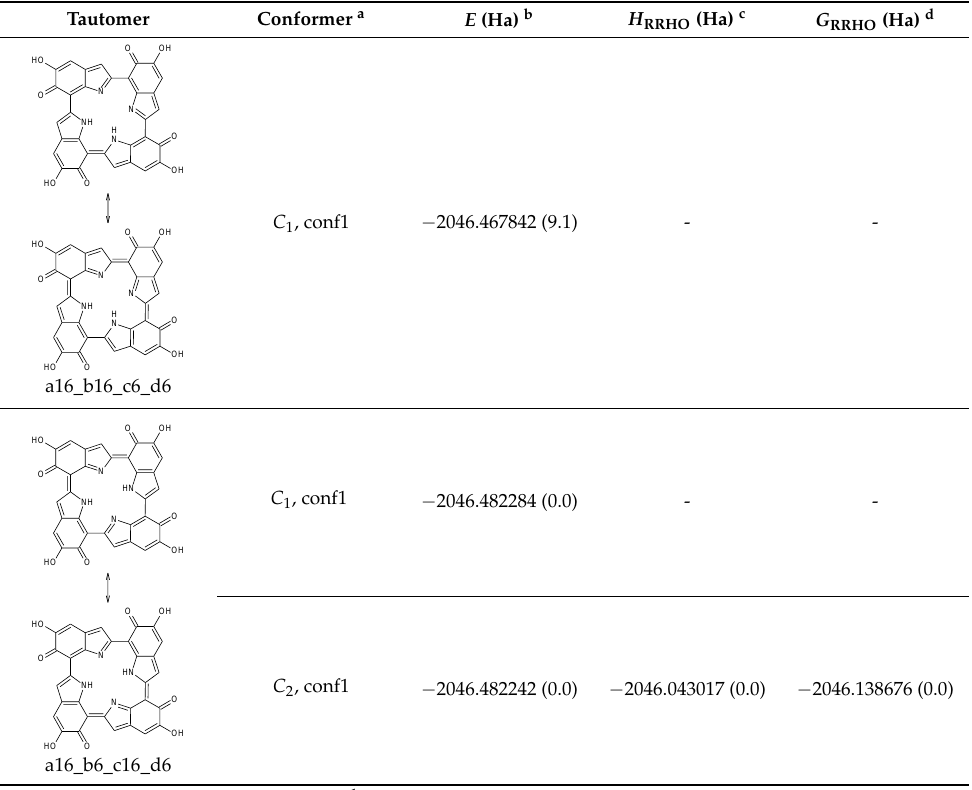
Table 13. KP-6e, neutral form in water.